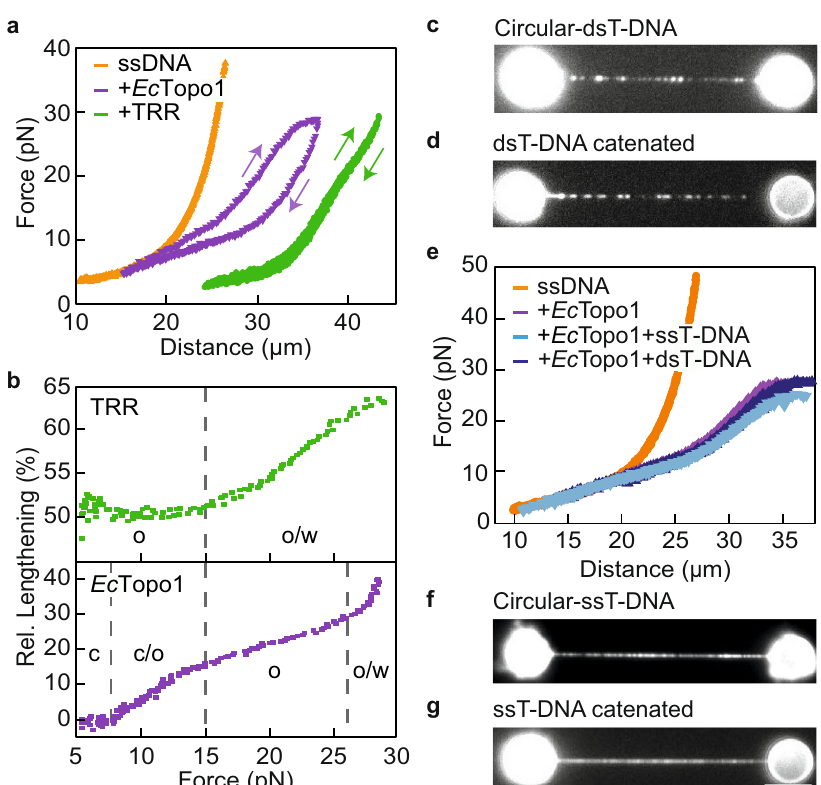
Fig. 5 Binding and catenation of dsT- and ssT-DNA to tethered ssDNA by Ec TopoI. a Representative FD-curves (from N ≥ 30) of bare ssDNA (orange), TRR-ssDNA (green) and Ec TopoI-ssDNA (purple). Upwards and downwards arrows indicate extension and retraction curves, respectively. b ‘ Subtraction plots ’ showing the relative (rel.) lengthening for TRR-coated ssDNA (top, green) and Ec TopoI-coated ssDNA (bottom, purple) compared to bare ssDNA. These plots were generated from the FD-curves shown in panel ( a ). Dashed grey lines highlight the transitions (c/o, o/w) between the closed (c), open (o) and widened (w) states of the topoisomerase-ssDNA gate. c Representative intercalator fl uorescence image (from N ≥ 5) of circular dsT-DNA bound to Ec TopoI-ssDNA in standard buffer. d Representative intercalator fl uorescence image (from N ≥ 5) of circular dsT-DNA obtained after moving the substrate shown in panel ( c ) into high-salt buffer. e Representative FD-curves (from N ≥ 5) of bare ssDNA (orange), Ec TopoI-ssDNA (purple) and Ec TopoI-ssDNA in the presence of either ssT-DNA (light blue) or dsT-DNA (dark blue) in standard buffer. f Representative intercalator fl uorescence image (from N = 4) of circular ssT-DNA bound to Ec TopoI-ssDNA in standard buffer. g Representative intercalator fl uorescence image (from N = 4) of circular ssT-DNA catenated around ssDNA obtained after moving the substrate shown in panel ( f ) into high-salt buffer. Scale bar represents 5 µ m, and applies to all snapshots. Source data are provided as a Source Data fi